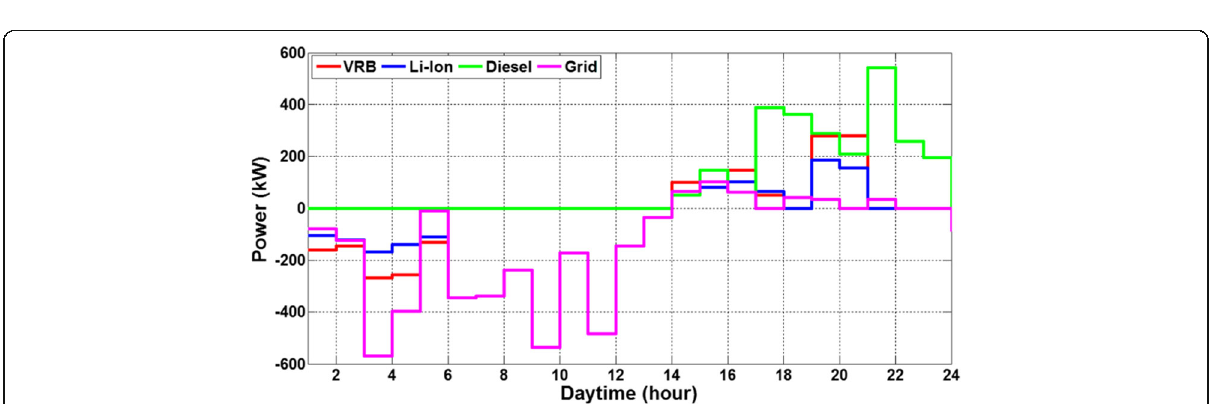
Fig. 15 Energy resources dynamic scheduling using GA in non-isolated operation mode